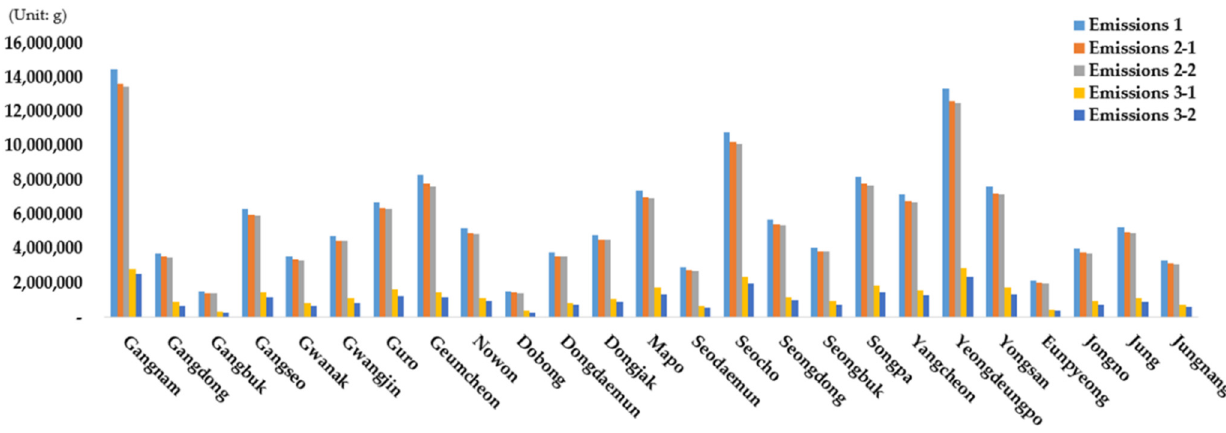
Figure 14. Scenario 2 vehicle emissions and emissions ratio by autonomous district ( Gu ).